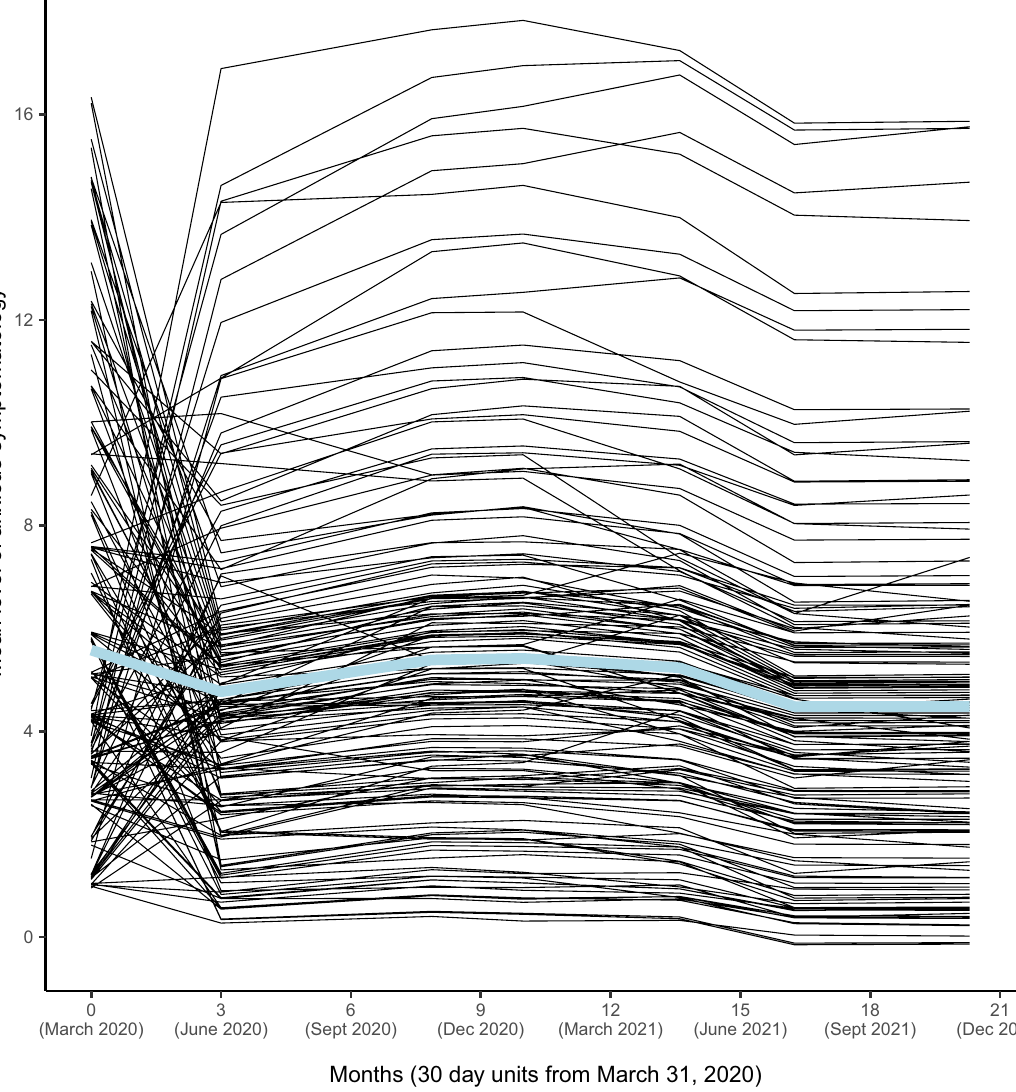
Figure 2. Individual change profiles in anxiety across modifications in social distancing protocols (SDPs). Through a 20-month period from the introduction of SDPs to their